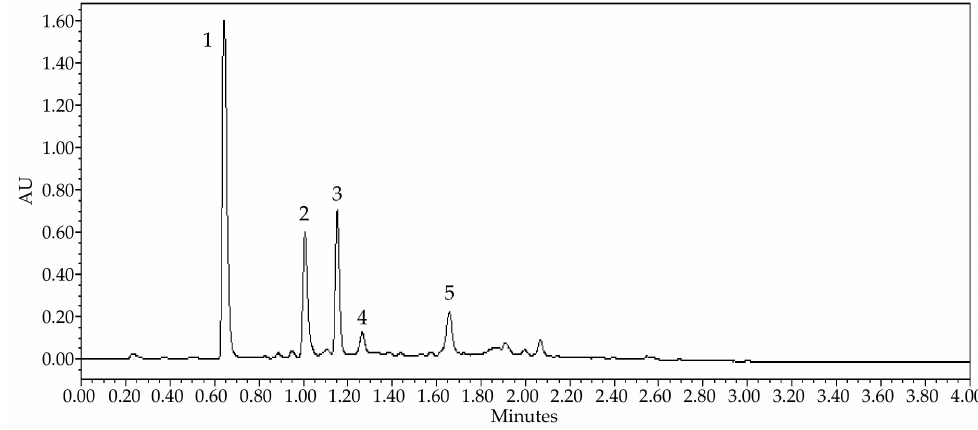
Figure 1. UV Max plot chromatogram of guarana seed extract at 0.0–4.0 min. Key: 1, caffeine; 2, catechin; 3, epicatechin; 4, A-type procyanidin dimer; 5, A-type procyanidin dimer. AU = absorbance units.